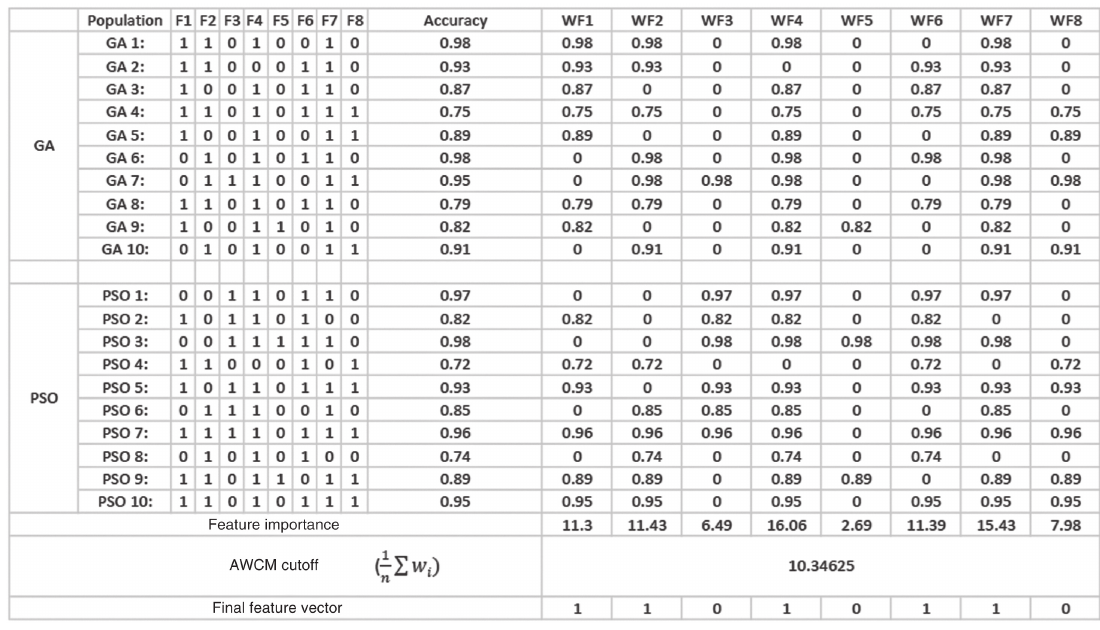
Figure 1: A hypothetical example to illustrate the concept of AWCM in order to measure the importance of a feature to be considered in the final and optimal